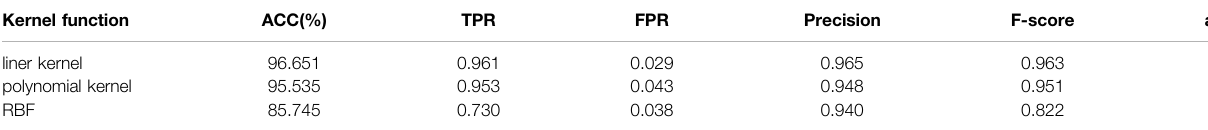
TABLE 3 | Performance comparison of hybrid features under different kernel functions. Kernel function